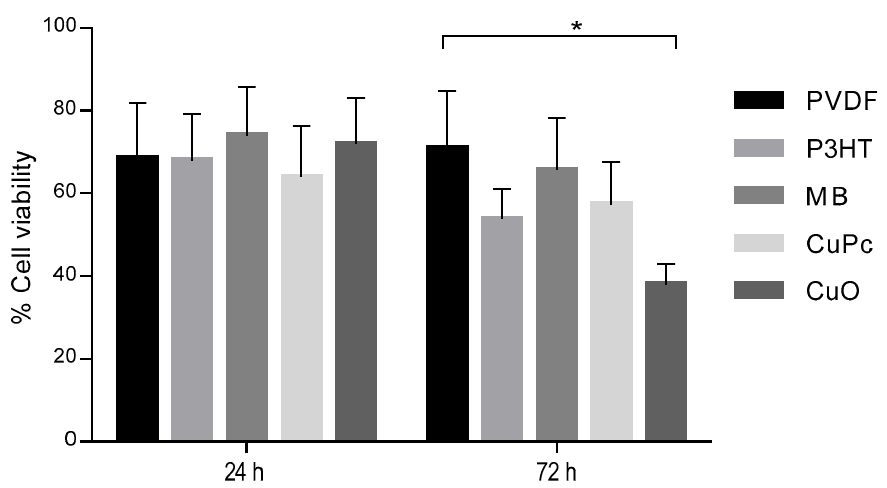
Figure 5. Comparative in vitro studies of PVDF, P3HT, MB, CuPc, and CuO electrospun fibers: cyto- toxicity tests. All the results were normalized with respect to the positive control (TCP) representing the 100% of cell viability. (* p < 0.05).